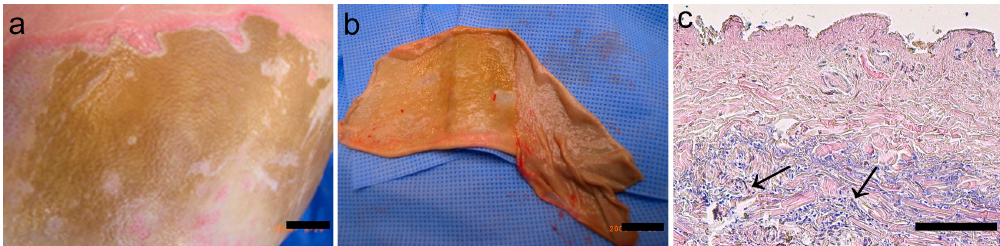
Figure 1. Macroscopic pictures and morphology of human eschar tissue. ( a ) Eschar tissue on patient; ( b ) Eschar after tangential excision; ( c ) Eschar at interface of non-viable and viable tissue from which acellular Burn Wound Extract (BWE) is derived (see Materials and Methods); hematoxylin and eosin staining showing the absence of epidermis; small, rounded cells are present in the lower levels of the dermis (areas with blue nuclei; see arrows). Scale bar = 1 cm ( a , b ) or 200 µm ( c ). Table 1. Characteristics of burn wounds, properties of the burn wound extract (BWE) and experiments where each BWE donor was used.